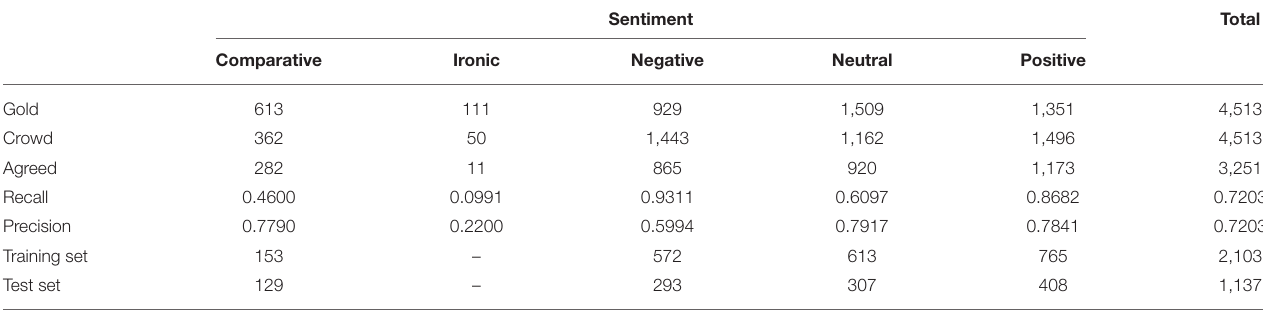
TABLE 2 | Dataset #1: Facebook comments on commercial products.